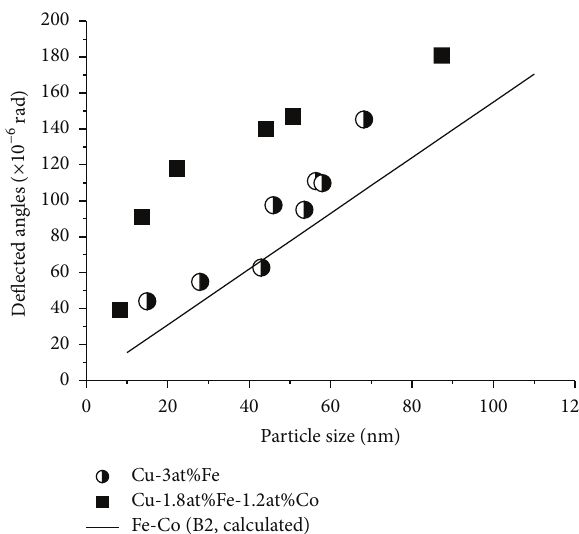
Figure 8: Deflected angles of parasitic reflection of Cu-1.8at%Fe- 1.2at%Co and Cu-3at%Fe